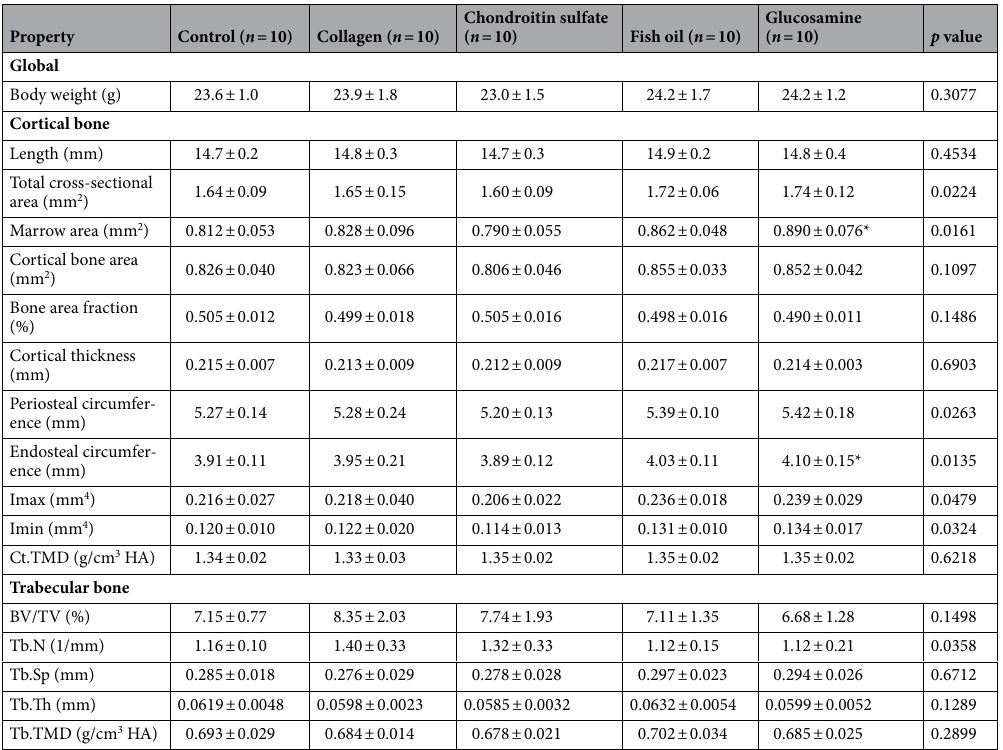
Kruskal Wallis p values are